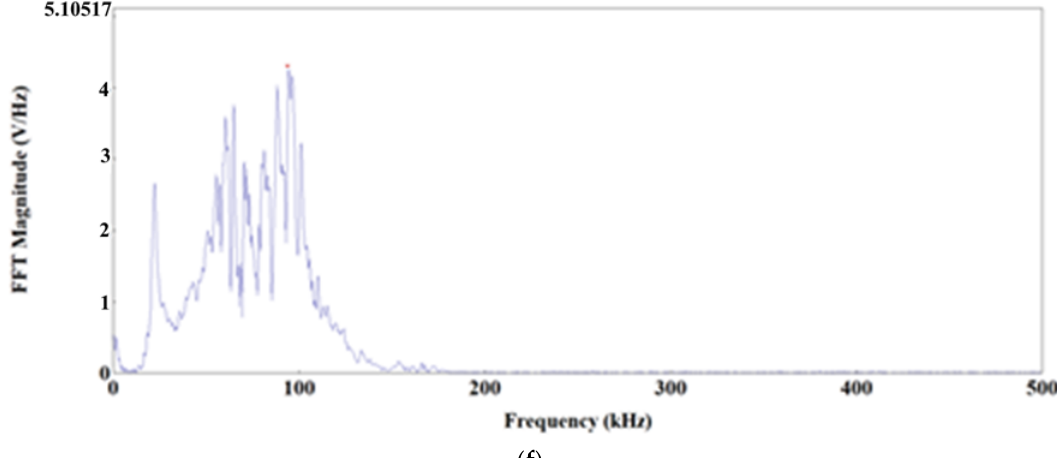
Figure 15. Time-frequency spectra for the 1100 – 1200 s time range: ( a , d ) Waveform Time Domain graphs, ( b , e )Waveform Continuous Wavelet graphs, ( c , f ) FFT Magnitude graphs.